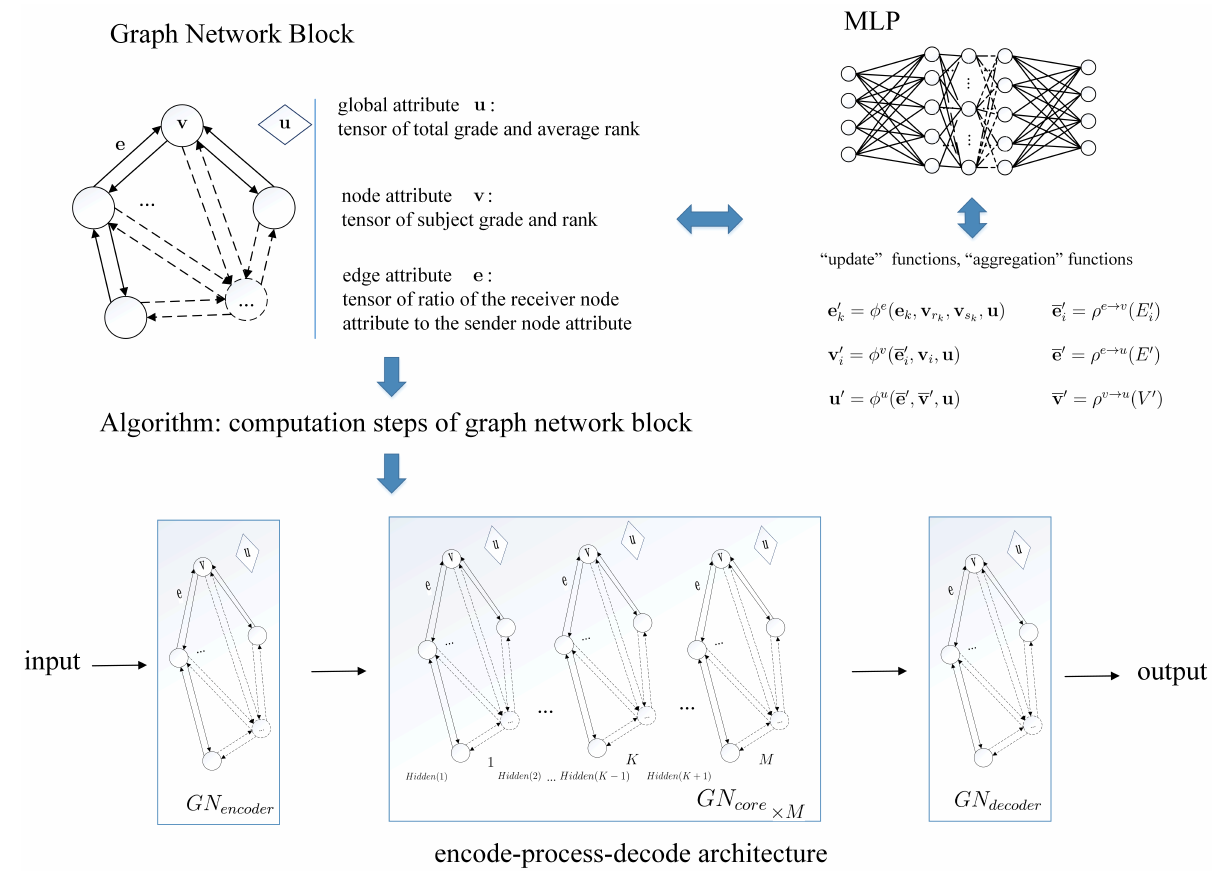
Figure 7. Graph neural network model for grade